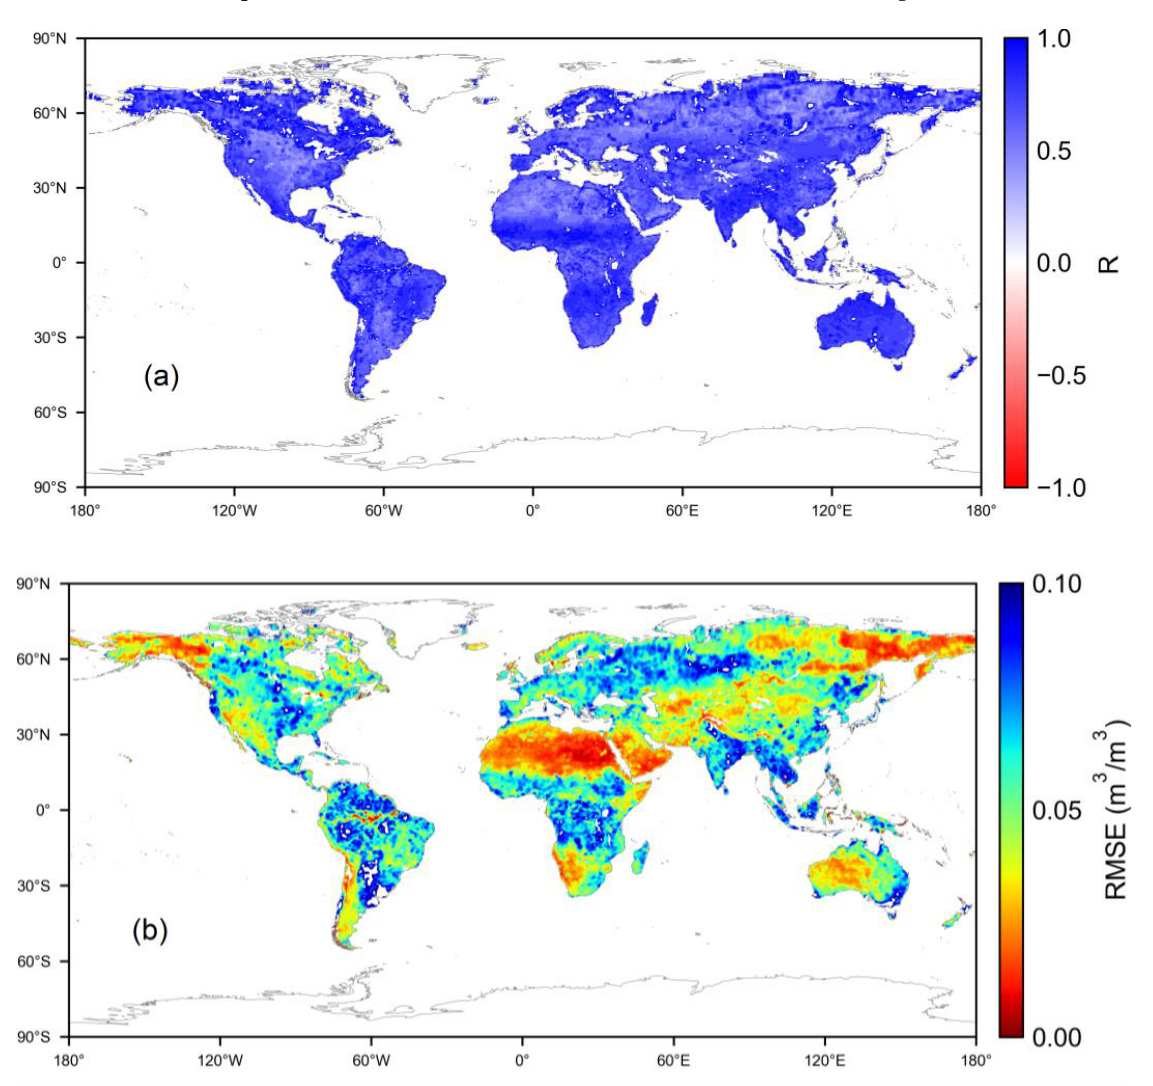
Figure 4. The statistical metrics of ( a ) R and ( b ) RMSE (m 3 /m 3 ) between the predicted SM values and NN-SM of the testing samples.